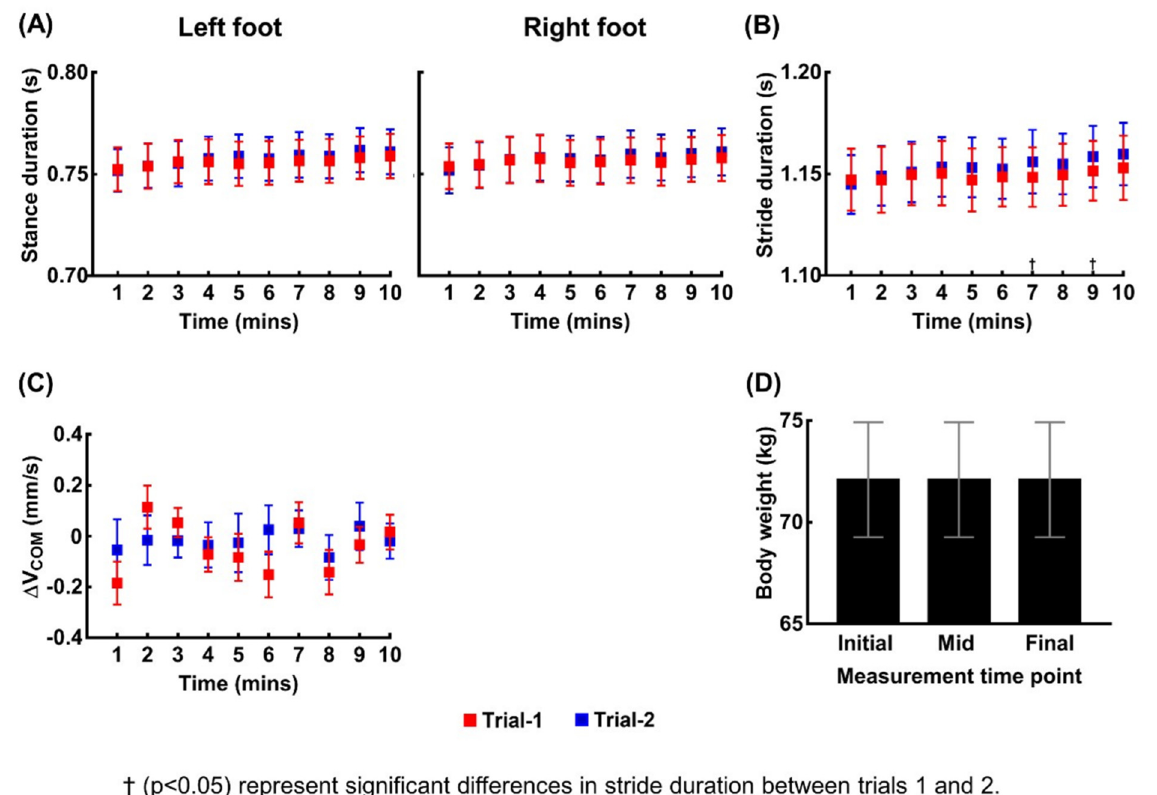
Figure 3. The measures used to assess whether the time-dependent decrease in the VGRF is due to alterations in kinematics or dynamics during walking. ( A – C ) show the means and standard error bars of the stance durations of the both feet, stride durations, the difference in the values of the vertical center of mass velocity between the beginning of one stride and the next one ( ∆ V COM ) for 20 participants averaged over every one-minute time interval for the two trials. ( D ) shows the means and standard error bars of the body weights (BW) for 20 participants for three measurement time points: initial (before the first trial), mid (between the first and second trial), and final (after completion of the second trial). BW remained exactly same for all participants across the three time points. Table 2. The results of two-way repeated measures ANOVA performed for a sanity check.